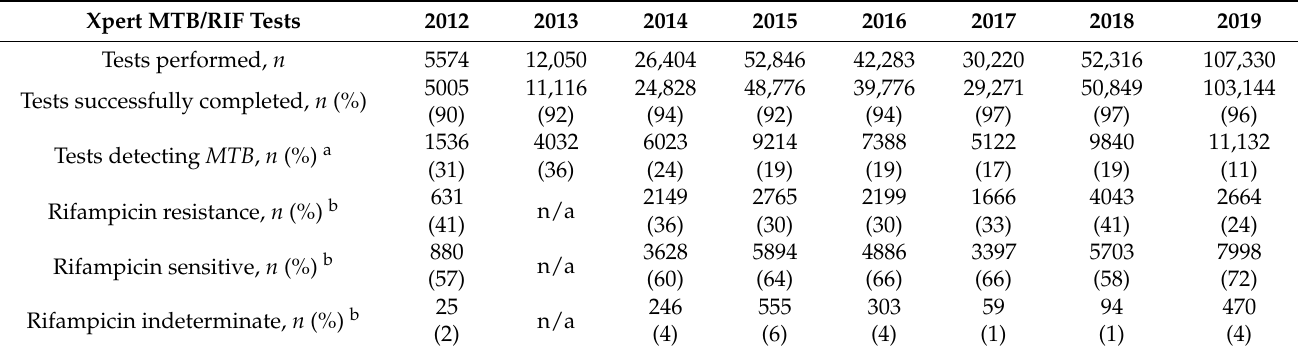
Table 2. Performance and results of Xpert MTB/RIF tests in Uzbekistan from 2012 to 2019.